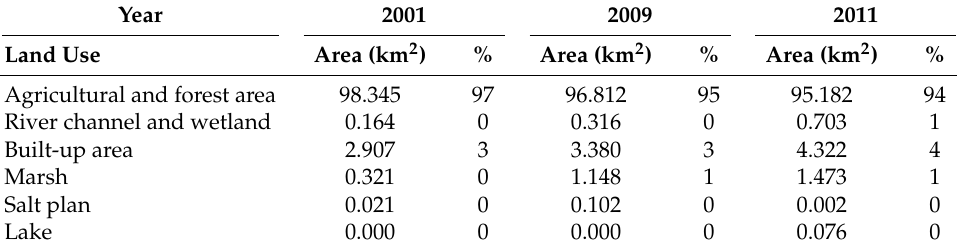
Table 3. General land use classification.